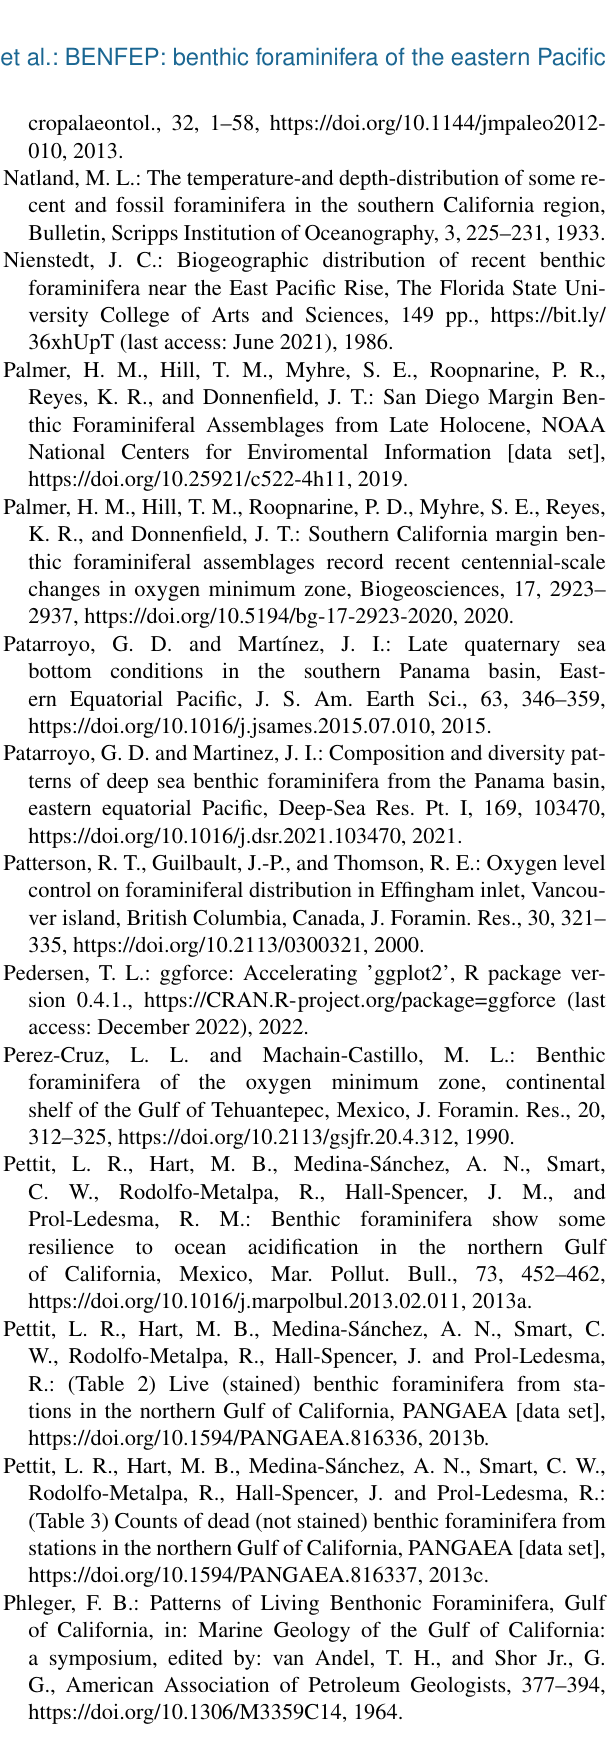
R.: (Table 2) Live (stained) benthic foraminifera from sta- tions in the northern Gulf of California, PANGAEA [data set],